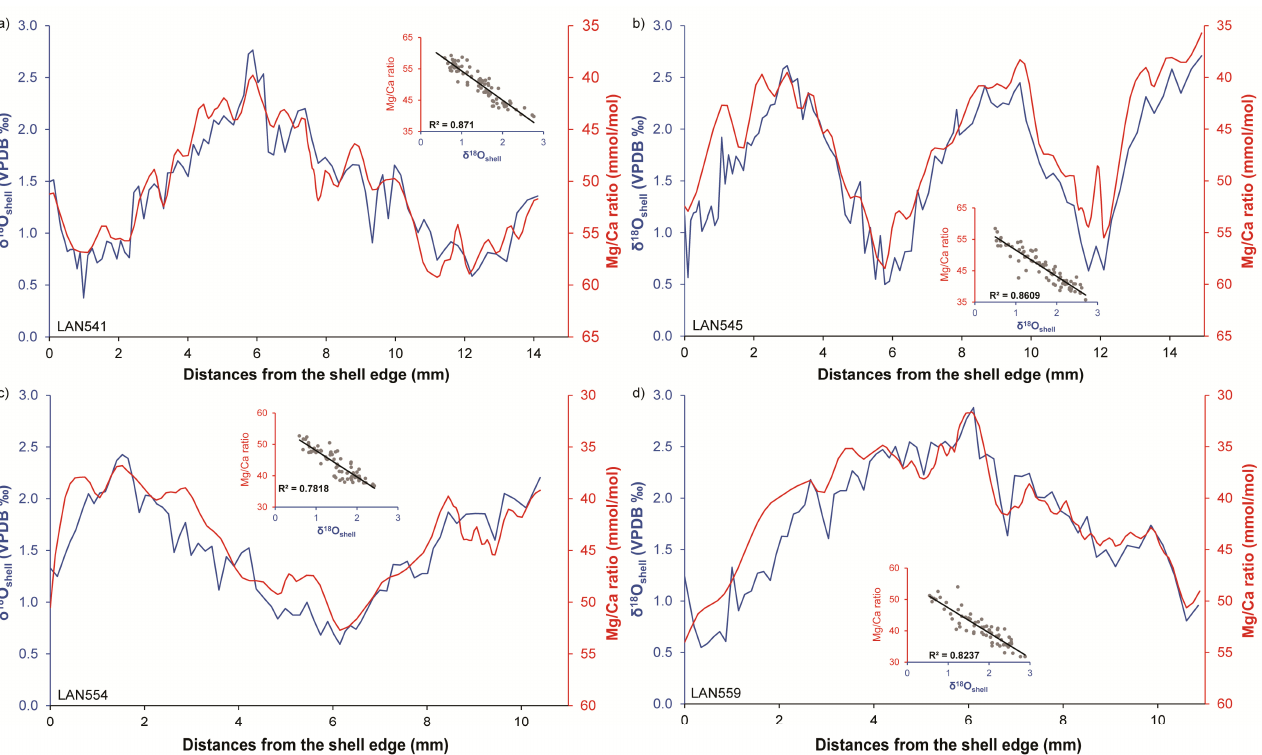
Figure 8. Mg/Ca ratio and δ 18 O shell series obtained from ( a ) LAN541, ( b ) LAN545, ( c ) LAN554, and ( d ) LAN559. LIBS derived Mg/Ca ratios were aligned with δ 18 O shell series according to major growth lines observed through limpet cross-sections (Figure 3b) and the sclerochronological investigation previously conducted on these same specimens [72].